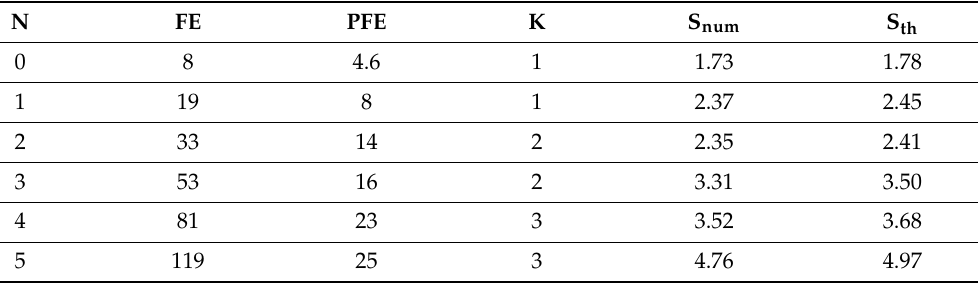
Figure 16. Dam break test case water height using PFE scheme for different N . FORCE discretization ( a ) and Lax–Friedrichs discretization ( b ) for constant n x = 1000 and λ = 10 − 4 shows the same numerical solution. Table 8. Dam break test case runtime and speedup using FE and PFE schemes with Lax–Friedrichs discretization for different N and constant n x = 1000 and λ = 10 − 4 shows significant speedup close to the theoretical